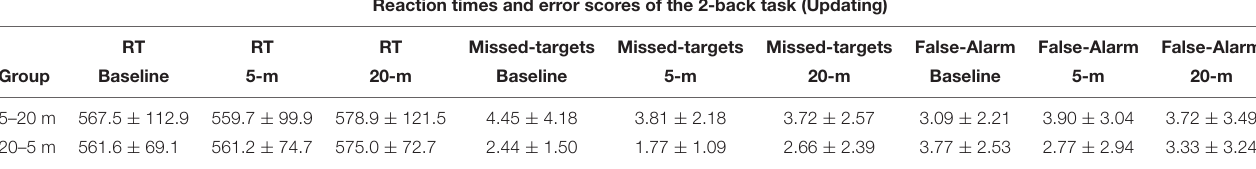
TABLE 3 | Reaction times (RT) and error scores of the 2-back task separated by test condition and experimental group. Reaction times and error scores of the 2-back task